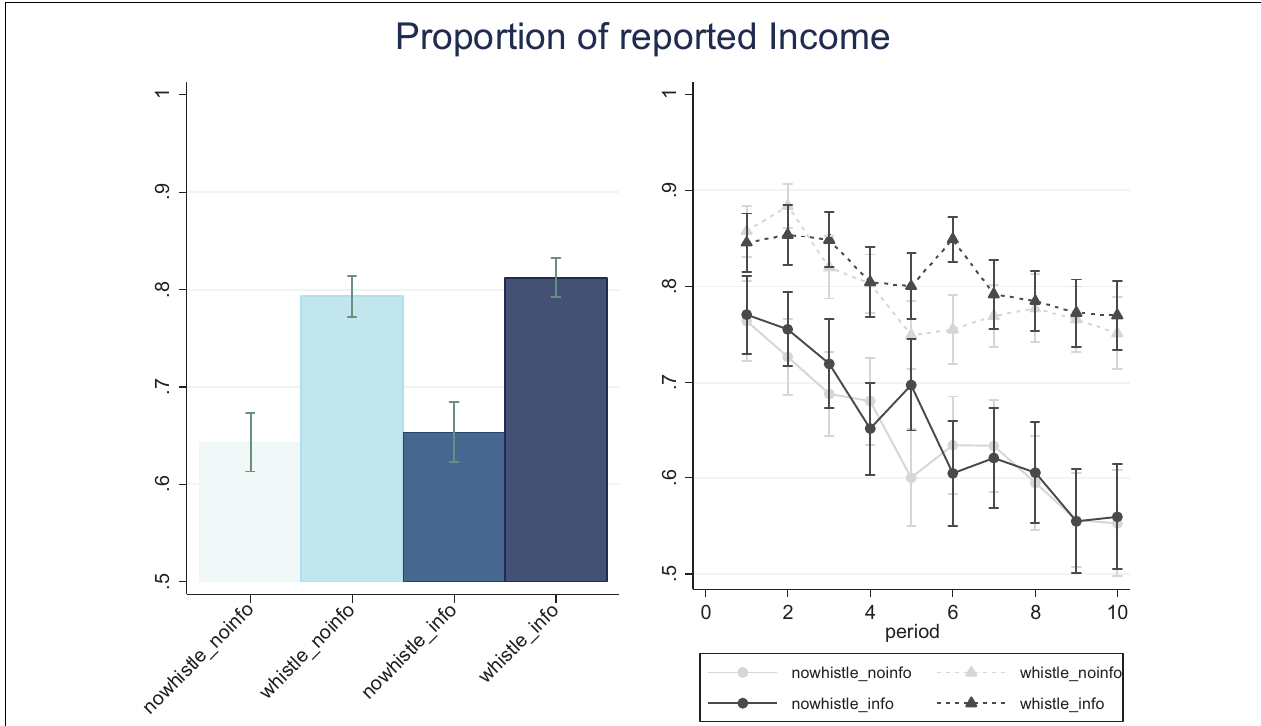
FIGURE 1 | Proportions of gross incomes declared by subjects in the tax evasion game, by treatment (left-handed Panel) e by treatment and period (right-handed Panel), N = 240. Error bars, mean ±